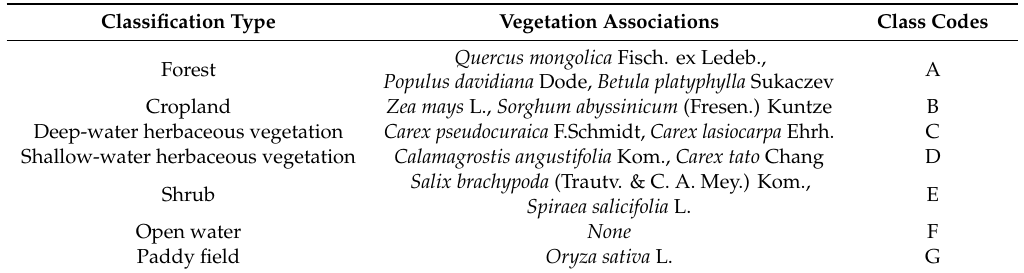
Table1. ClassificationtypesformappingmarshvegetationinHongheNationalNatureReserve(HNNR).